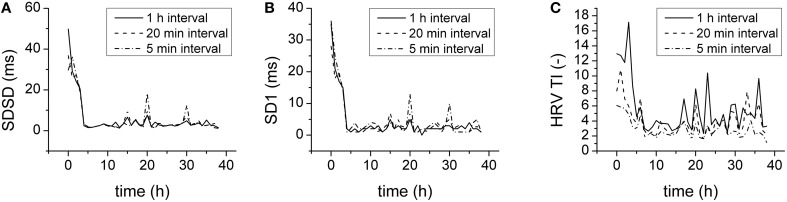
Duration of analysis and HRV parameters. (A) SDSD for 1 h (full line), 20 min (dashed line), and 5 min (dash-and-dotted line) analysis intervals. (B) SD1 for 1 h (full line), 20 min (dashed line), and 5 min (dash-and-dotted line) analysis intervals. (C) HRV TI for 1 h (full line), 20 min (dashed line), and 5 min (dash-and-dotted line) analysis intervals.